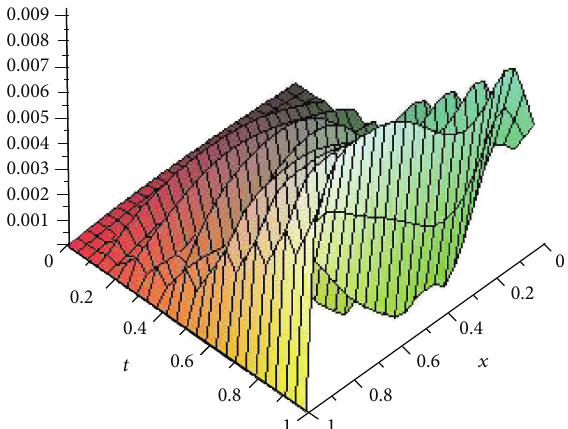
Figure 8: Plot of the absolute error 𝑒(𝑥, 𝑡) = |𝑦(𝑥,𝑡)−𝑦 𝑛,𝑘 (𝑥,𝑡)| with 𝑛 = 3, 𝑘 = 32 for Example 3.